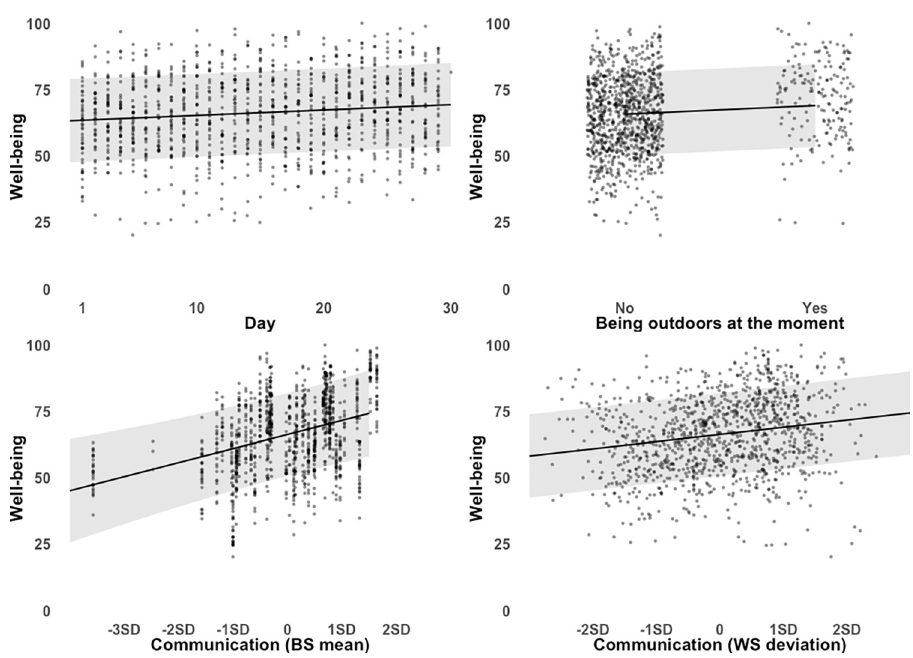
Fig 8. Predicted values of the well-being score for different values of day, being outdoors at the moment, and communication (between- and within-subject deviations). 95% confidence intervals are shown for predicted values (marginal effects) conditioned on fixed and random effects. Grey dots display the raw data points.